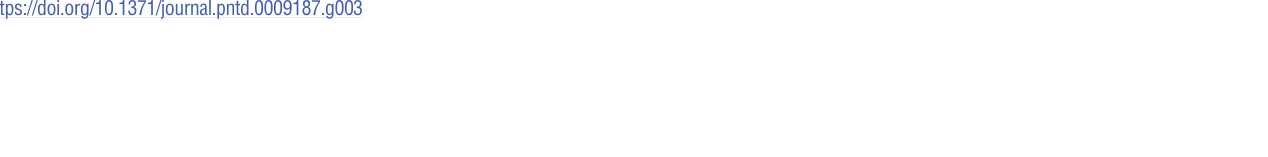
Fig 3. Median (Interquartile range (IQR)) CRP levels among (A) malaria, co-infection, and bacteremia and (B) the different causes of bacteremia, and median (IQR) PCT (C) malaria, co-infection, and bacteremia and (D) the different causes of bacteremia. Legend: the dotted line represents the cut-off values for CRP and PCT